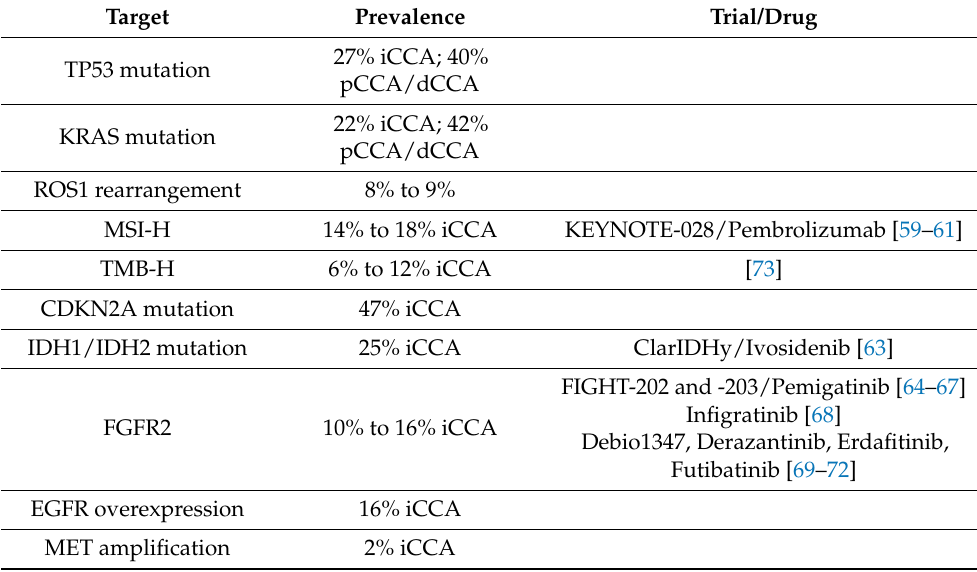
Table 1. Genetic variants in CCA as possible effective therapeutic targets and ongoing clinical